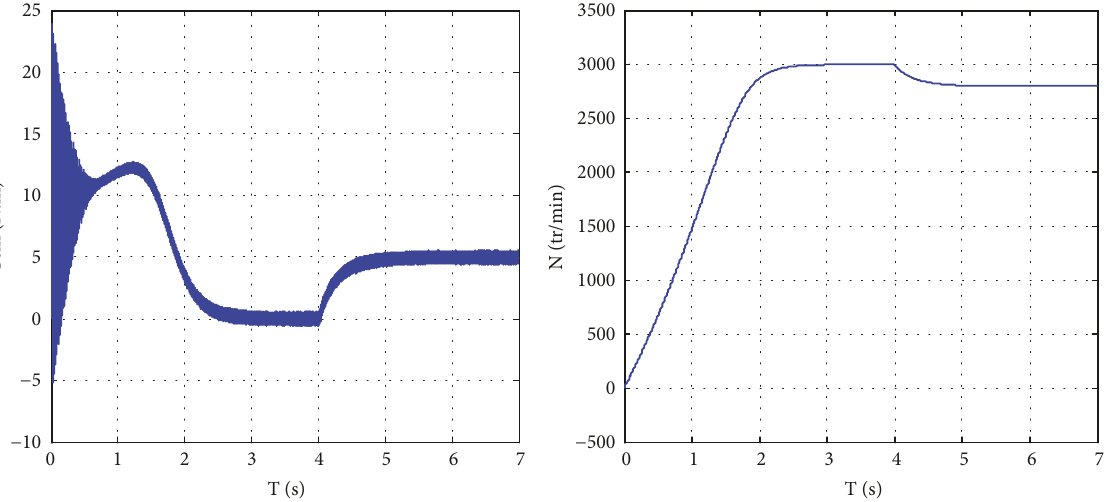
Figure 8: Electromagnetic torque and rotational speed for m = 3.